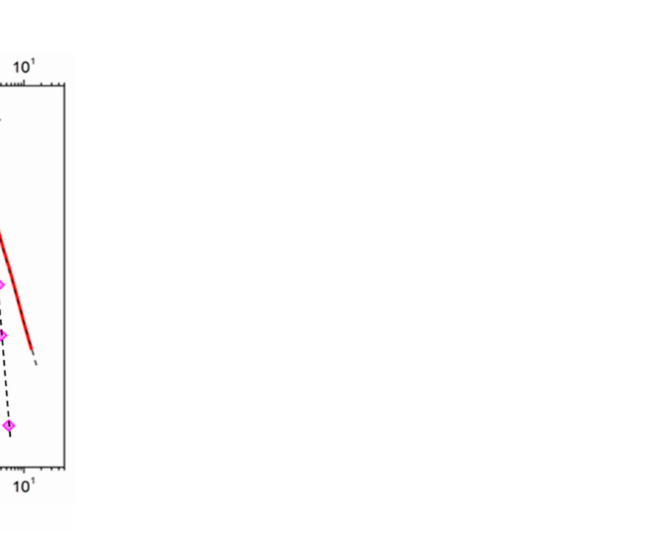
Figure 54. Concentration dependence of the diffusion coefficients of α -casein [139], globular pro- Figure 53. Generalized concentration dependence on concentration of the self ‐ diffusion coeffi ‐ teins [130], and linear flexible polymers [132]. The master curves for globular proteins (blue exper- cients of globular proteins molecules [130]. The figure shows the experimental values for BSA (pH imental points) and flexible linear polymers (red solid line) are shown. The asymptotes with the = 4.8–5.2), myoglobin (pH = 6.8–7.2), lysozyme (pH = 2.9–3.0 and pH = 7.4–7.8), barstar (pH = 8.0– 8.2). The solid line is the generalized self ‐ diffusion coefficients concentration dependence of the slopes of φ − 0 , φ − 3 , and φ − 12 are indicated. Solid magenta diamonds represent the concentration flexible ‐ chain polymers [132]. φ(cid:3549) –critical concentration, found as the intersection of the asymptote dependence of the diffusion coefficient of α -casein < D > / D 0 normalized by with zero slope ϕ − 3 , drawn to the experimental concentration dependences of the self ‐ diffusion coefficients of